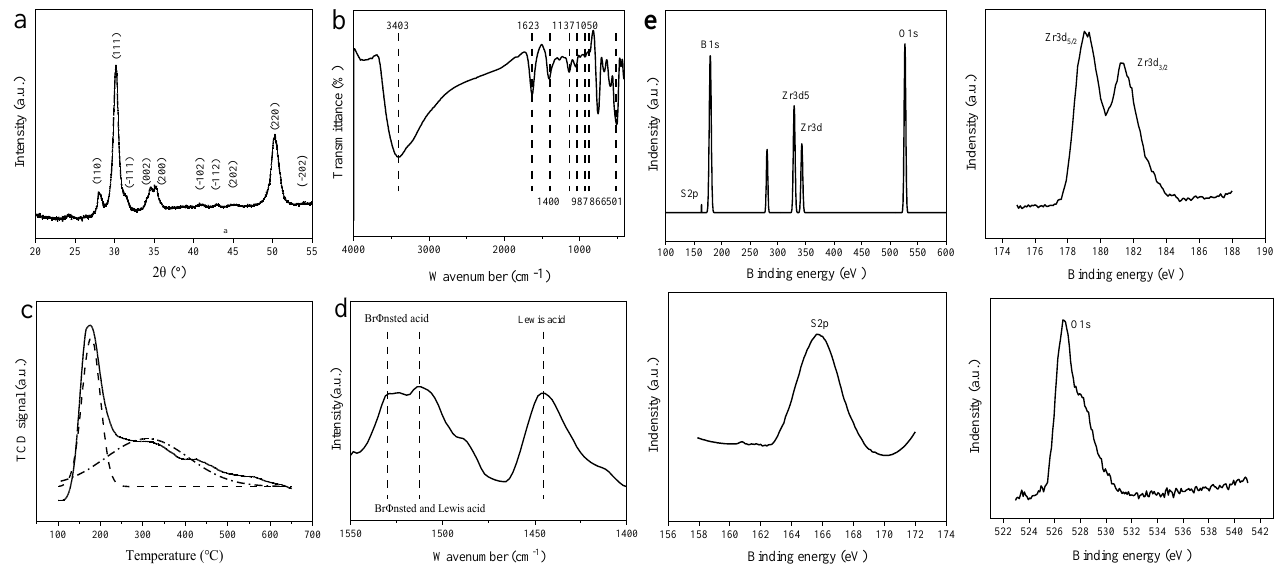
Figure 2. Acid properties and structure characterization of catalysts. ( a ) XRD pattern; ( b ) FTIR spectra; ( c ) temperature programmed desorption; ( d ) FTIR spectra of pyridine chemisorption; ( e ) XPS pattern.